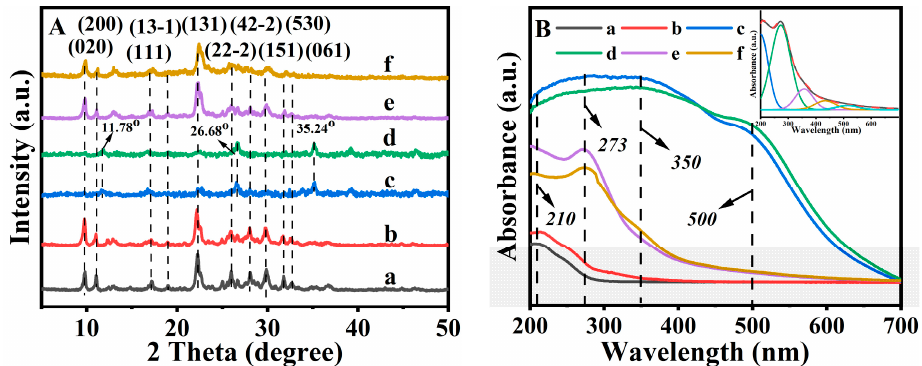
Figure 1. XRD patterns ( A ) and diffuse reflectance UV-vis spectra ( B ) of CP (a), NH 4 − CP (b), Fe(0.03) − H(0.00) − CP − 9 (c), Fe(0.06) − H(0.00) − CP − 9 (d), Fe(0.03) − H(0.05) − CP − 9 (e), and Fe(0.06) − H(0.07) − CP − 9 (f).